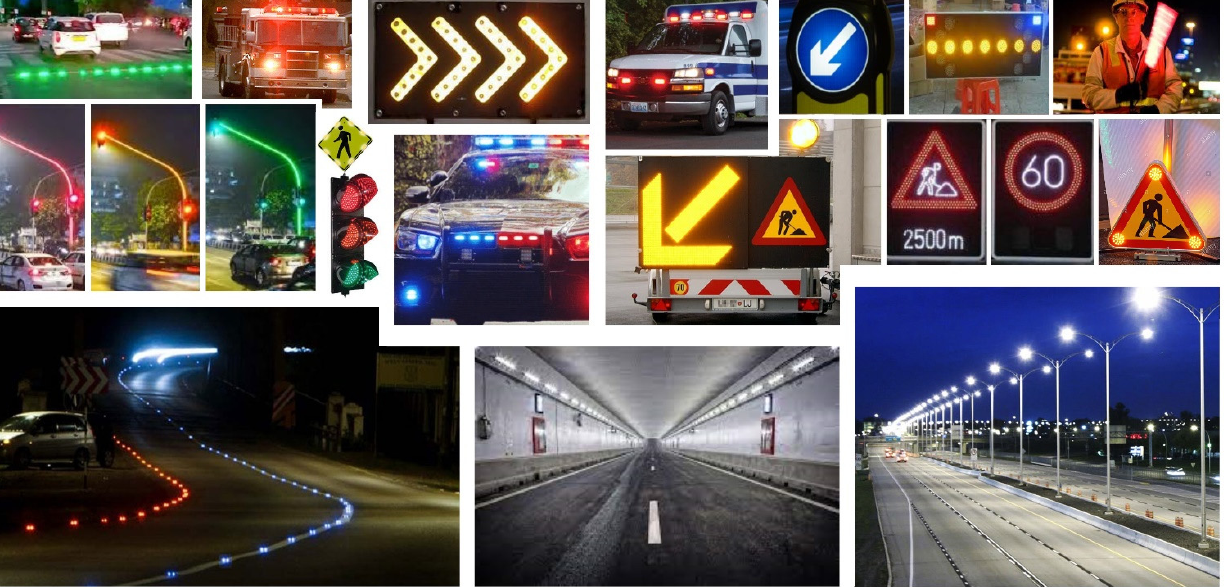
Figure 1. LED-based lighting solutions integrated in vehicles and in road transportation infrastructures. This wide diffusion facilitates the deployment of the VLC technology.